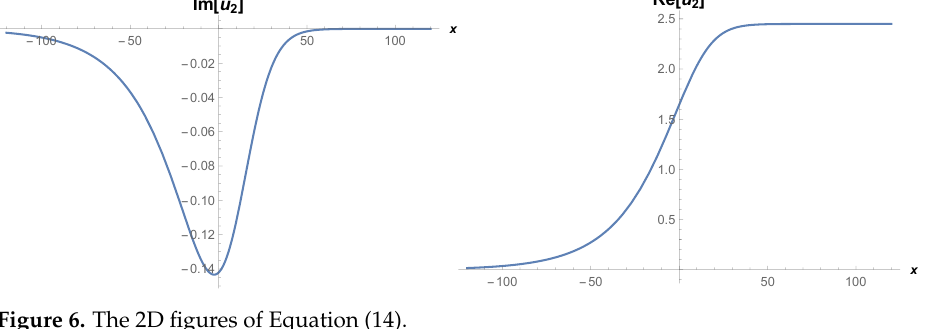
Figure 6. The 2D figures of Equation